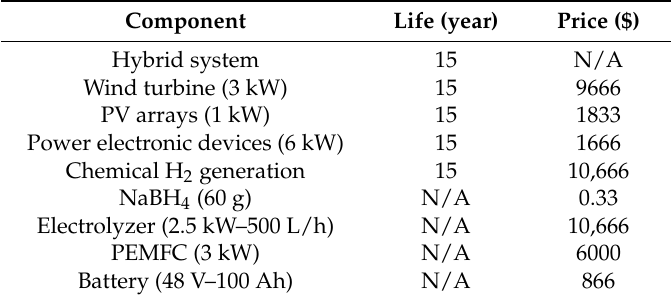
Table 4. Component life and price